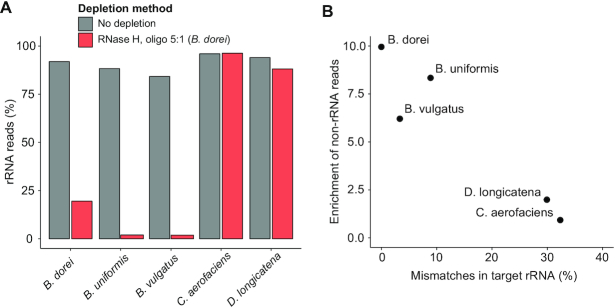
Oligo probes can be applied to closely related species. (A) Proportion of rRNA-aligning reads of total mapped reads (% rRNA reads), for un-depleted and RNase H-depleted samples using an oligo probe library designed for Bacteroides dorei across closely related species (Bacteroides uniformis and Bacteroides vulgatus) and distantly related species (Collinsella aerofaciens and Dorea longicatena). (B) Scatter plot between probe-to-target sequence similarity and fold enrichment of non-rRNA reads for five species. Probe-to-target sequence similarity was calculated as the average of percentages of base with mismatches in 16S and 23S rRNA alignments.